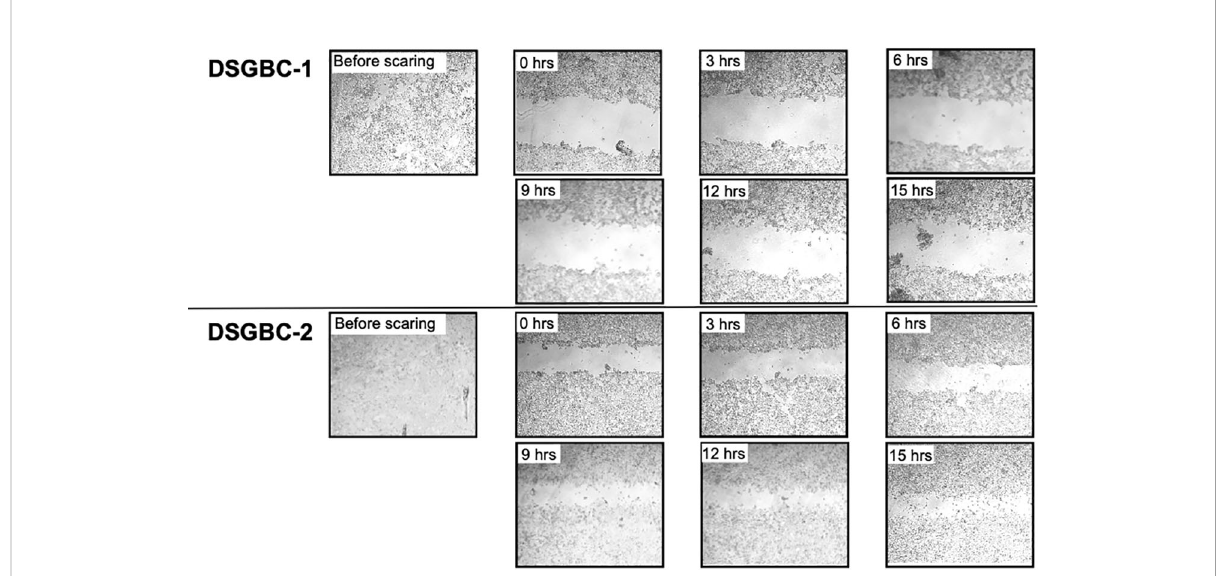
FIGURE 4 Breast cancer cells derived from a patient with obesity are faster in closing the space in a wound healing assay than the one derived from a patient with normal weight. Wound healing assay. Cells were plated to reach con fl uence within 24 h as described in Materials and methods . The invasion of the cell-free area was recorded every 3 h at the indicated time points. The cell-free areas were analyzed by Image J.